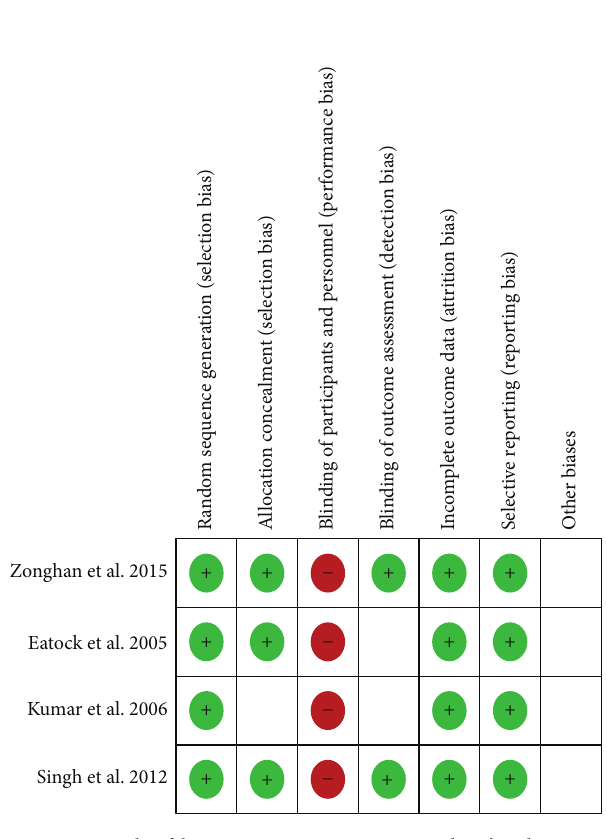
Figure 2: Risk of bias summary: reviewing authors’ judgements about the risk of bias for each item in each included